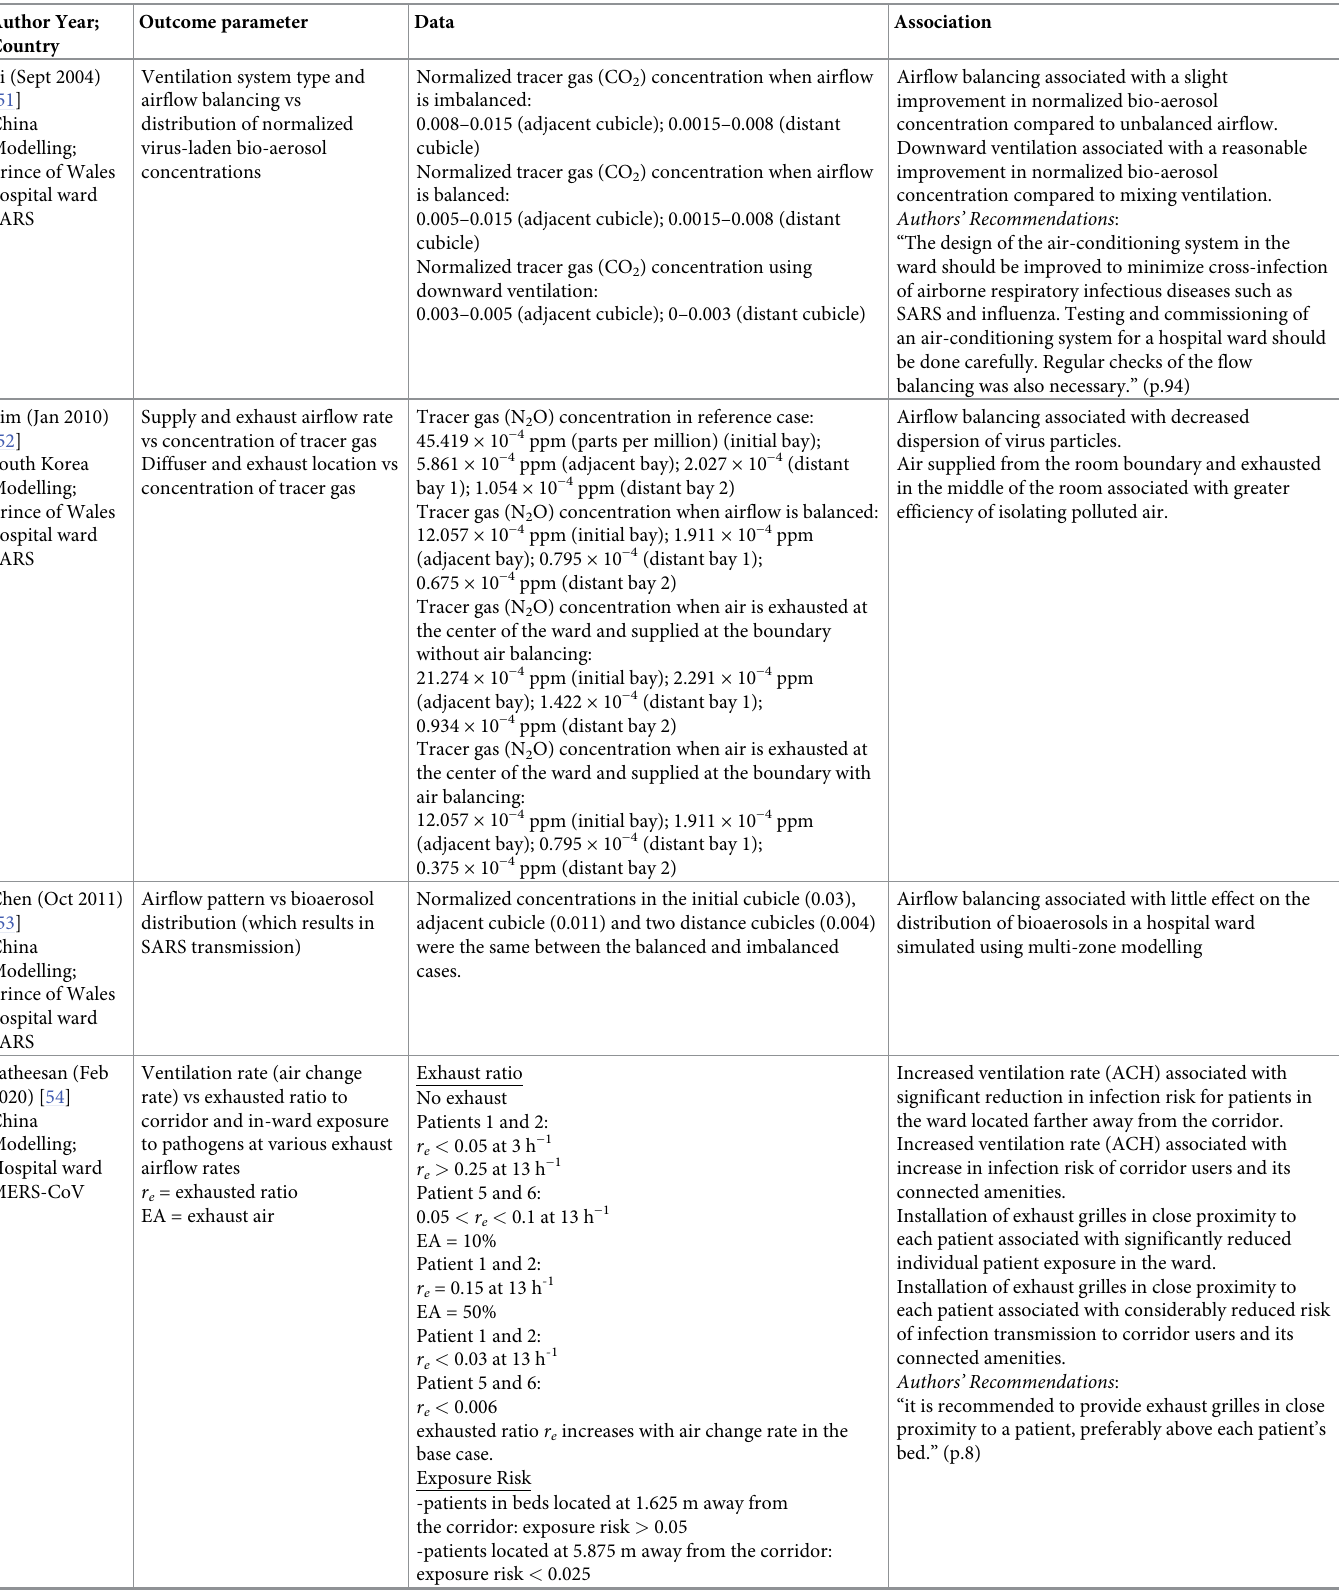
Table 5. Characteristics and results of studies examining combined effect of ventilation rate and airflow pattern on coronavirus transmission. Author Year;